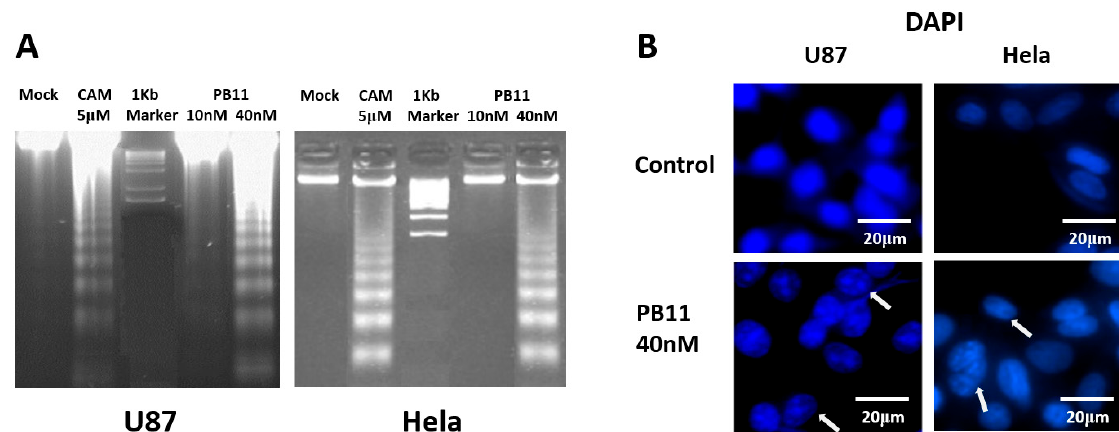
. Figure 3. Apoptotic fragmentation of PB11-treated cancer cells. ( A ) DNA fragmentation. U87 and HeLa cells were grown in 6-well culture plates with 10 or 40 nM PB11. After 48 h, the cells were harvested and lysed. DNA was precipitated by ethanol. As a positive control for DNA fragmentation, cells treated with 5 µ M camptothecin (CAM) were likewise investigated. ( B ) Nuclear fragmentation and condensation. Both cells were grown in 8-well culture plates with 40 nM PB11. The cell nucleus was stained using DAPI. Scale bar is denoted in